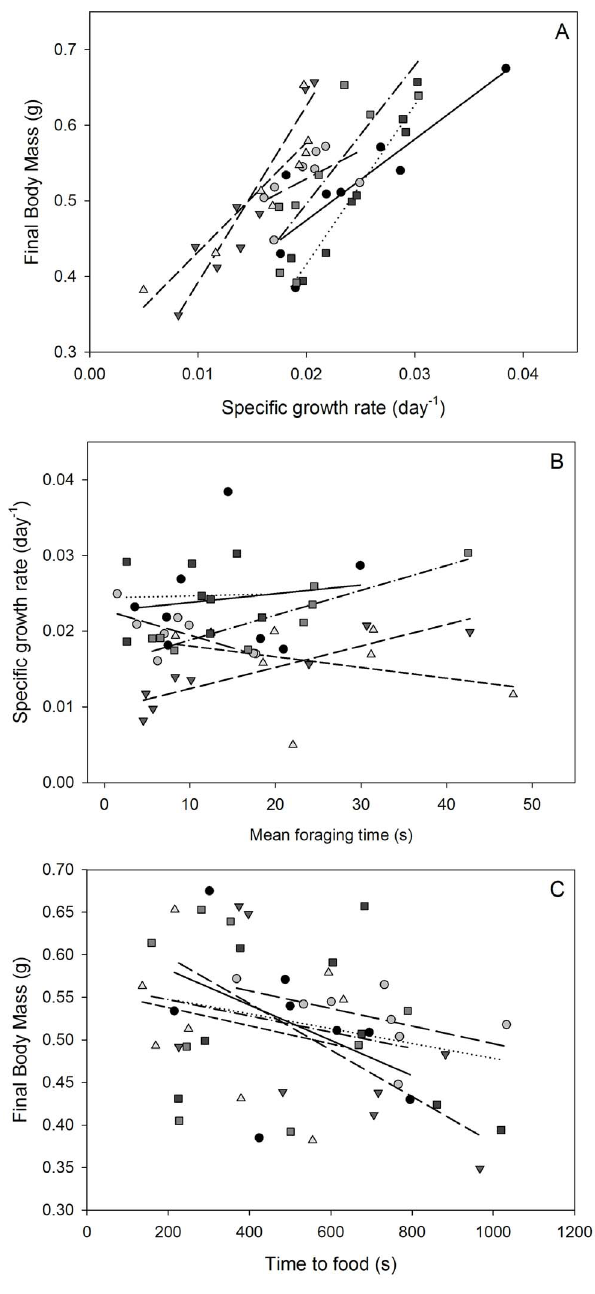
Figure 3. Behavioral analysis of initially similarly sized tadpoles that were set into groups at a premetamorphic stage (Gosner stage 29). Growth rate was associated with the final size of tadpoles after 5 weeks of group interactions (A) and the mean time that tadpoles spent foraging was associated with growth rates (B). Tadpoles that found or accessed food faster after 24 hours of food deprivation were the largest (C). Differing symbols and trend lines are for replicate tanks.